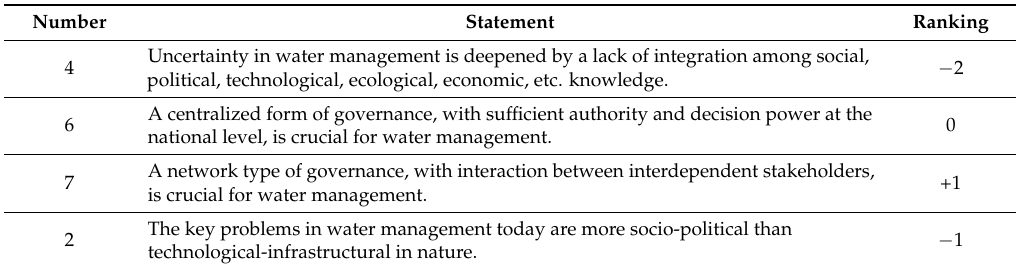
Table 15. Distinguished statements about IWRM in frame CH3.